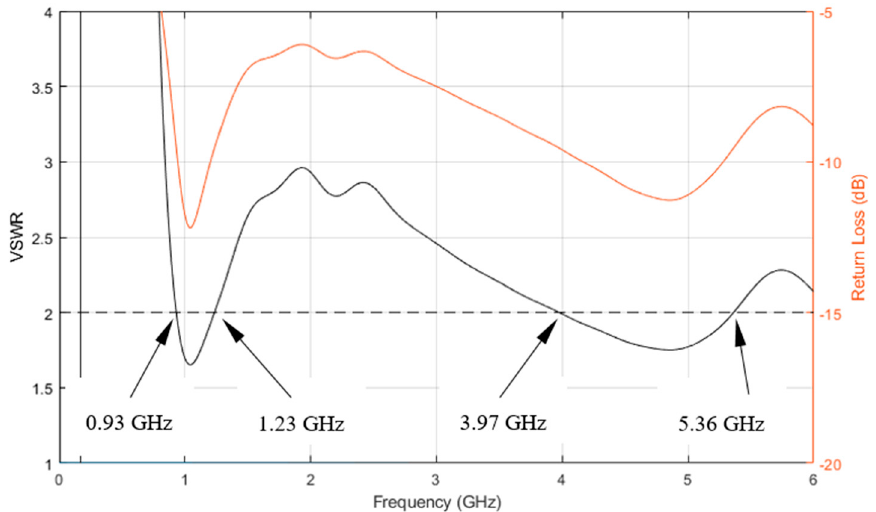
Figure 7. The input characteristics of the base MBA shown in Figures 4 and 6, and solid and dashed lines are obtained from our FD-TD solver and GEMS, respectively.